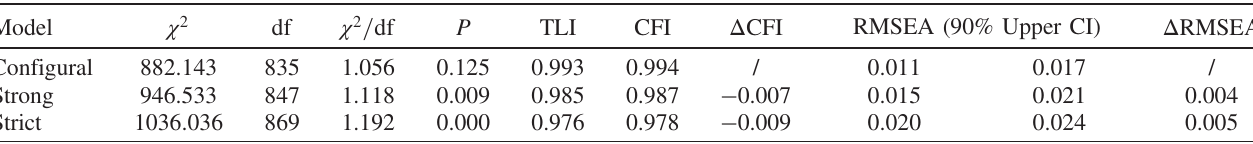
TABLE VII. Model fit statistics of the Eaton5M model of CSEM for longitudinal measurement invariance restrictions.